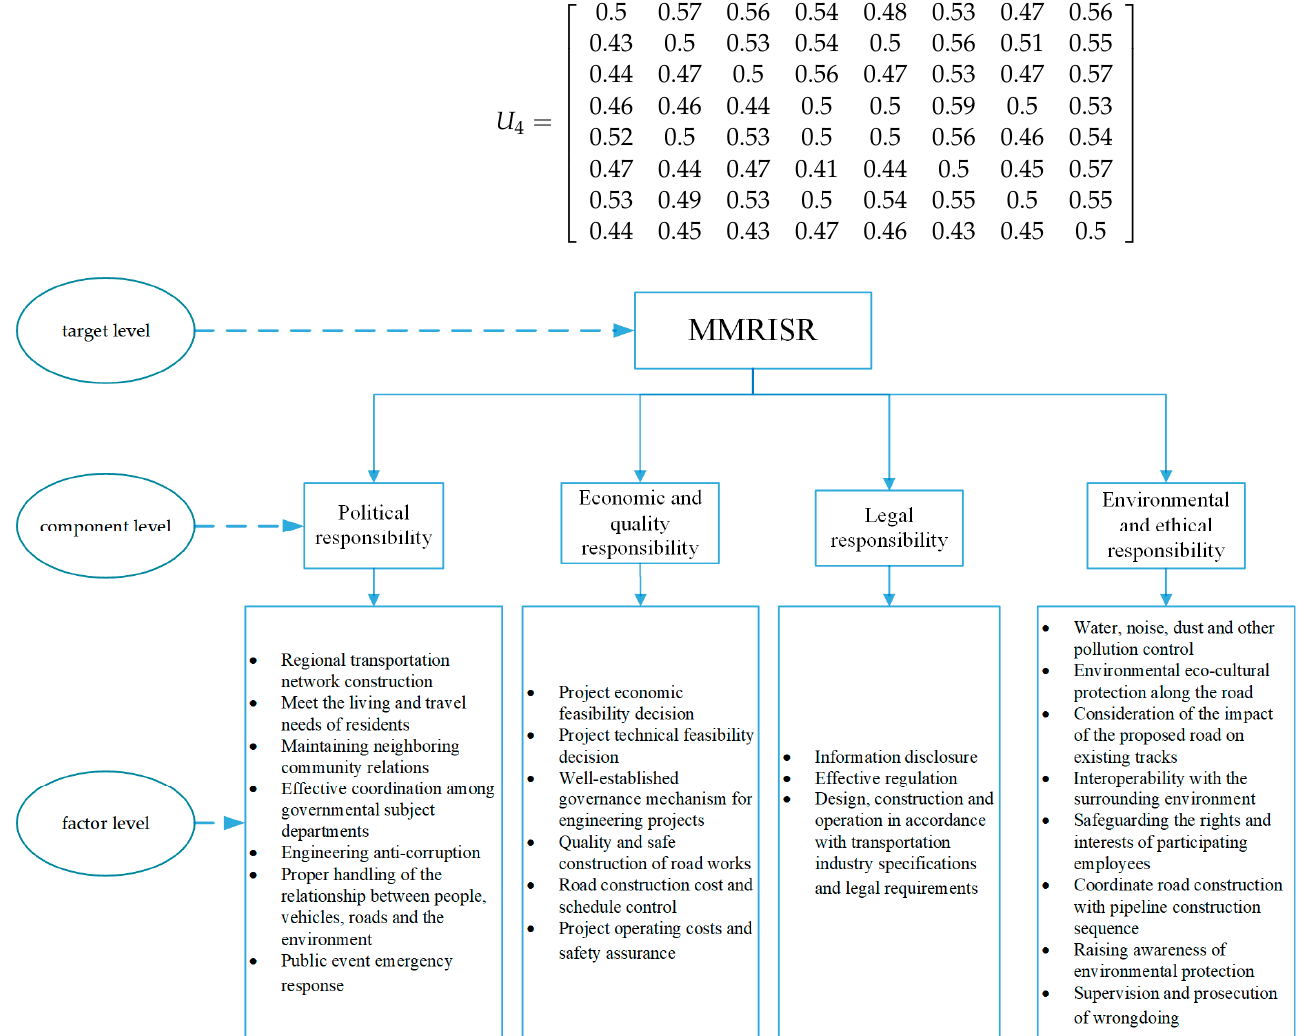
Figure 2. Hierarchy model of the MMRISR evaluation indicators.